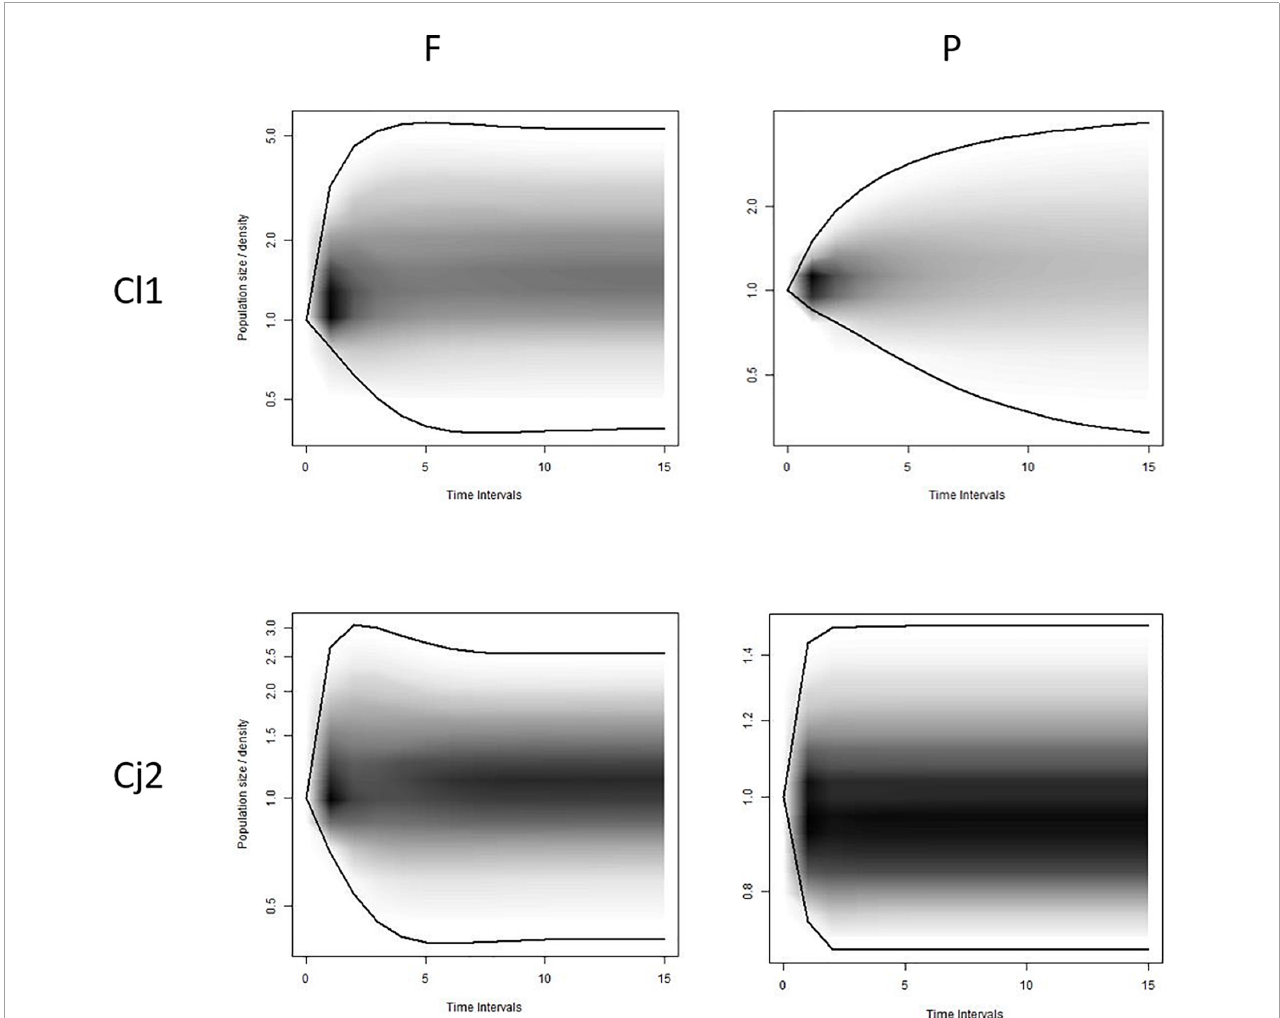
FIGURE4 Visualizations of transient dynamics for four selected sub-sites at different time periods showing the diversity of plausible transient responses. Data from; Cl1, Calibío Time period 1; Cj2, Cajibío Time period 2, (F) Forest, (P) Pasture. Decreasing Cj2P, stable, Cl1F and increasing Cj2F. y Cl1P the figure represents the diversity of transient dynamics as a function of the initial starting vector (the number of distribution of individuals at each stage). Darker shading indicates a higher probability of the population size in that range.